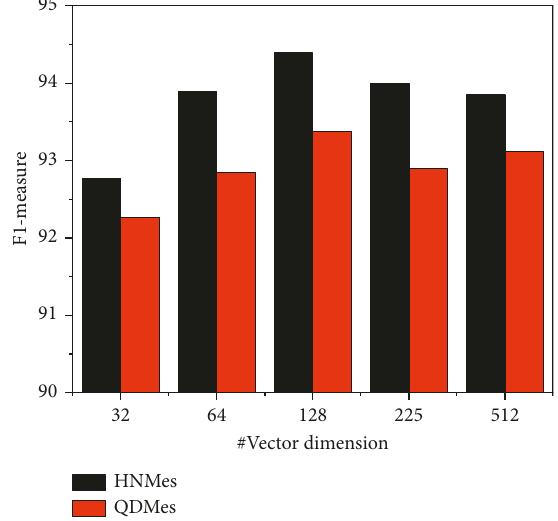
Figure 6: Performance of different vector